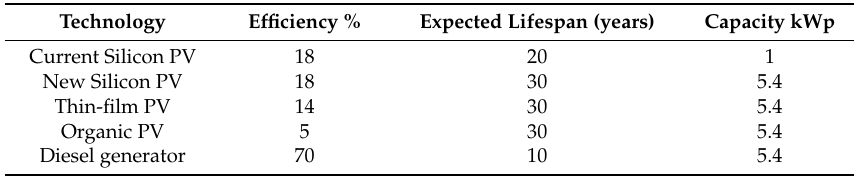
Table 1. Technical features of energy technologies, Las Calabazas, Cuba,